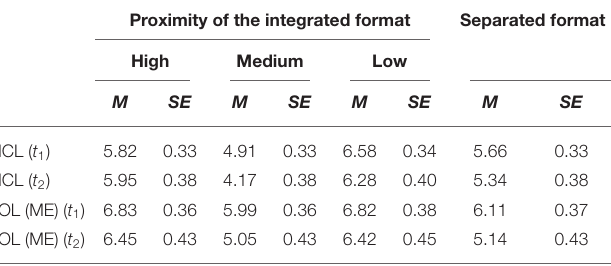
TABLE A1 | Descriptive data from Experiment 1.